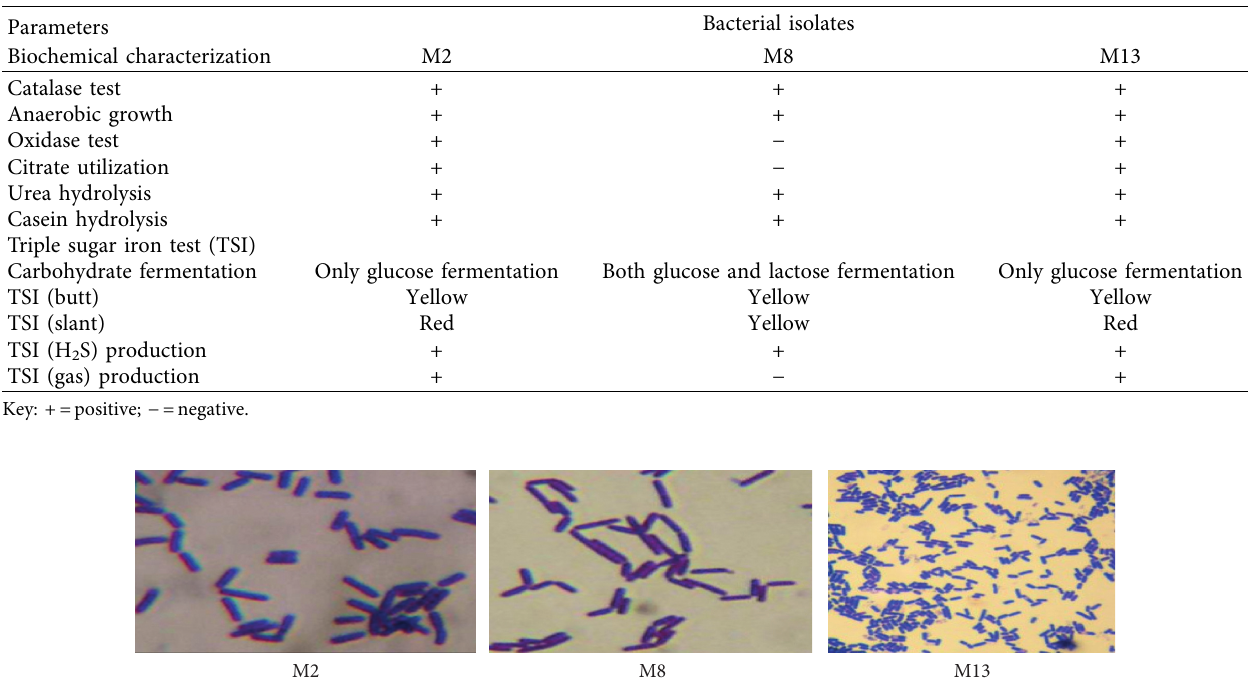
Figure 2: Results of Gram’s staining for the selected